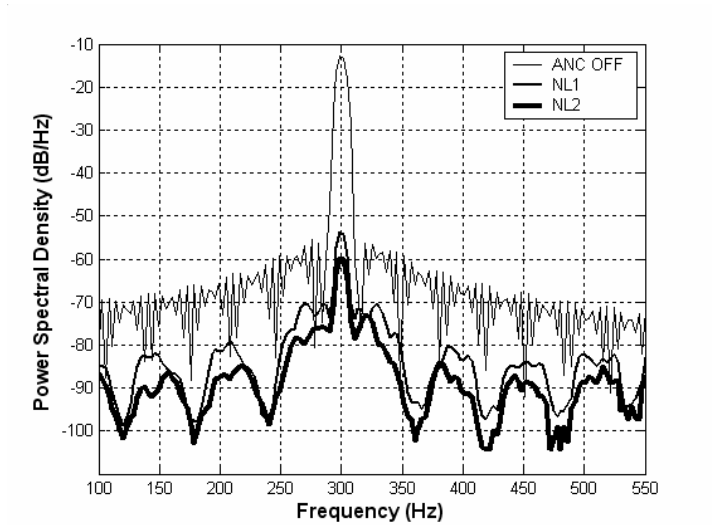
Fig. 8. The error signal spectrum for case 4.